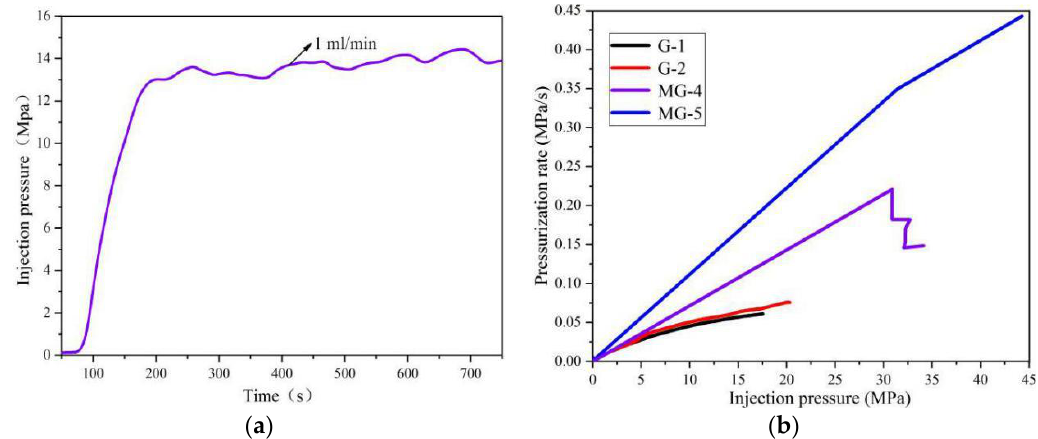
Figure 11. ( a ) Pressure-time curve of granodiorite at 1 mL/min injection rate and ( b ) pressurization ( a ) Pressure-time curve of granodiorite at 1 mL / min injection rate and ( b ) rate dP/dt versus injection pressure at different injection rates for the granodiorite and monzogranite pressurization rate dP / dt versus injection pressure at di ff erent injection rates for the granodiorite and monzogranite specimens.